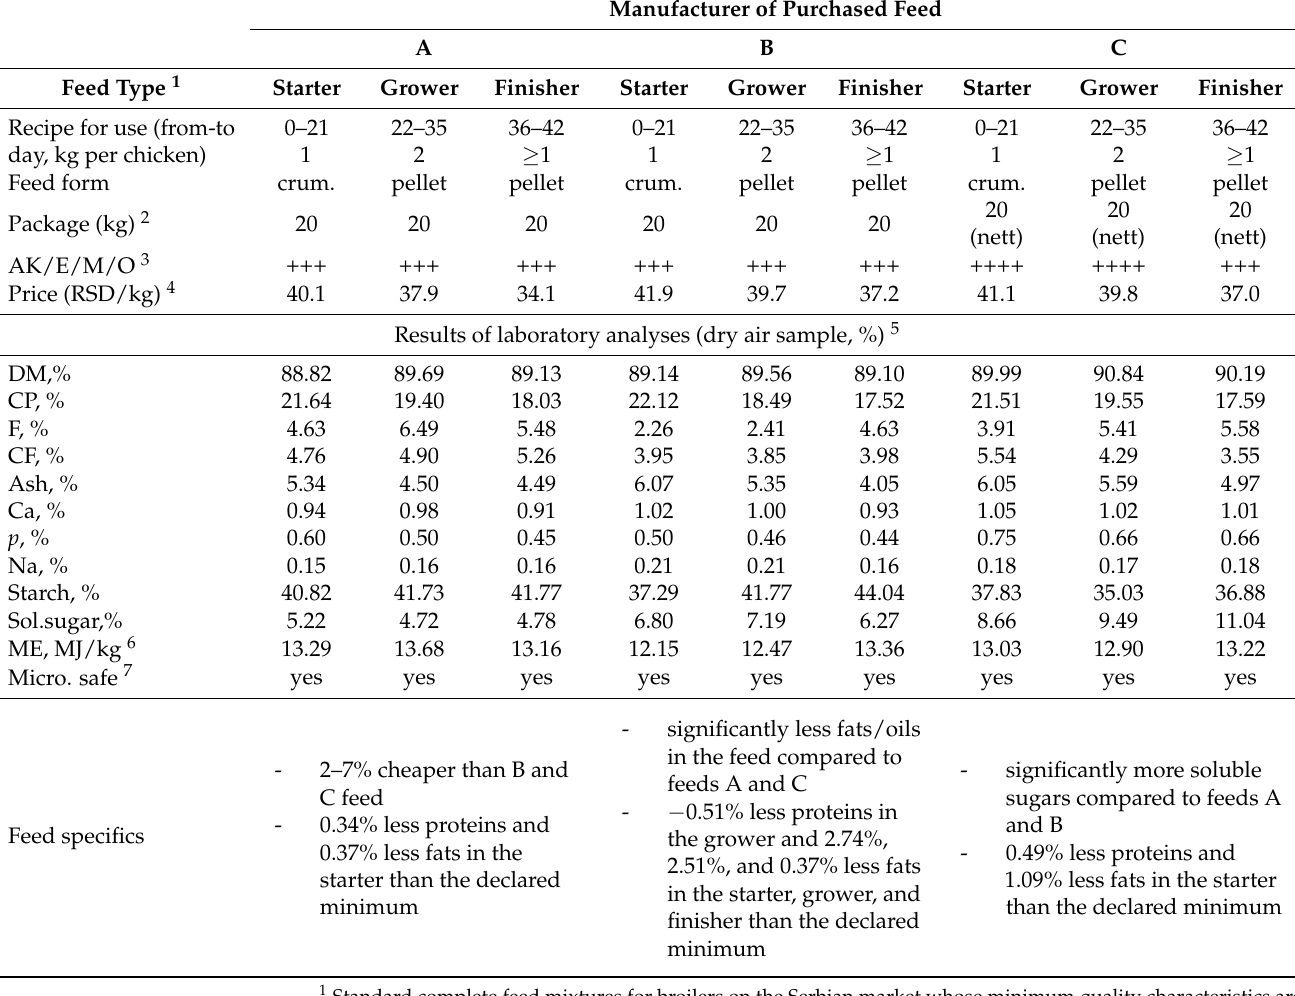
Table 2. Characterization of feed for broilers purchased on the Serbian market (before the biologi- cal